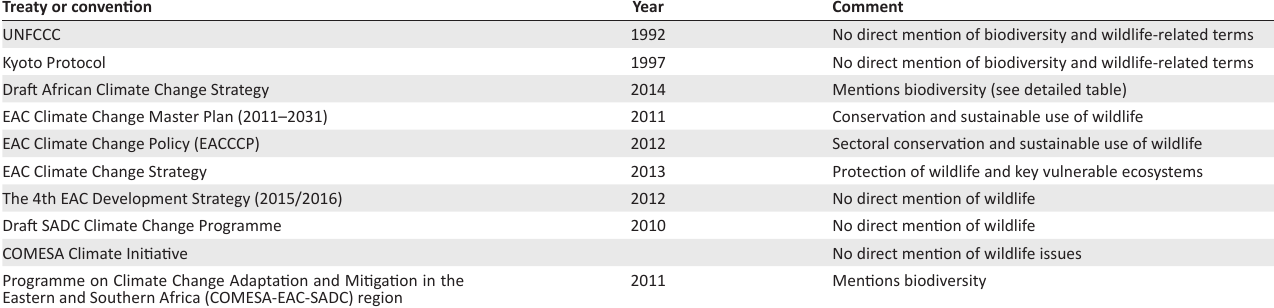
TABLE 2: Biodiversity and wildlife management–related provisions in international and regional climate change policies. Treaty or